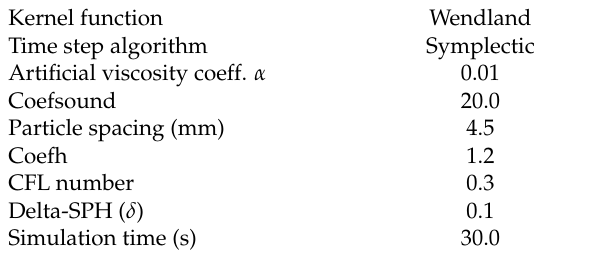
Table 7. The numerical setting in DualSPHysics (3D).